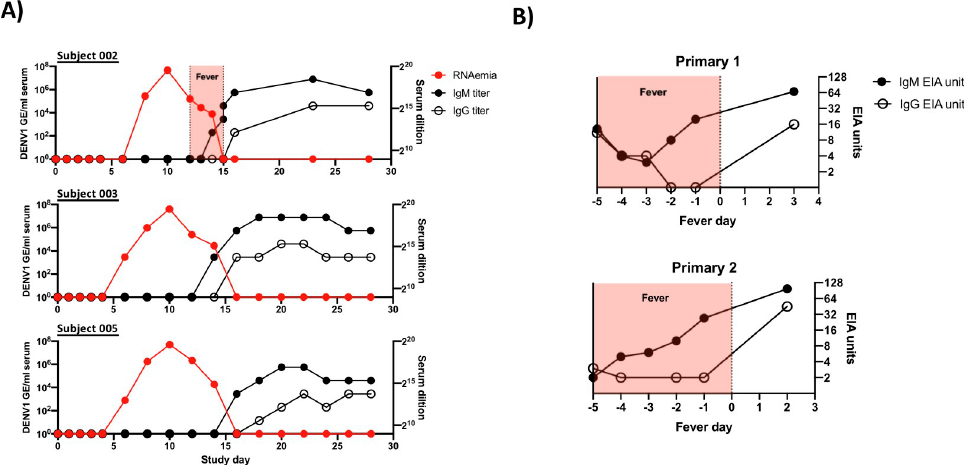
Fig 1. Subject characterization and experimental overview. A) Kinetics of RNAemia and DENV IgM/IgG seroconversion in experimental primary DENV-1 infection subjects. Serum IgM/IgG titers calculated as highest serum dilution providing a 2X signal over background. B) Kinetics of IgM/IgG seroconversion and duration of fever in natural primary DENV-1 infection subjects analyzed in this study. DENV-reactive serum IgM/IgG levels shown as EIA units.